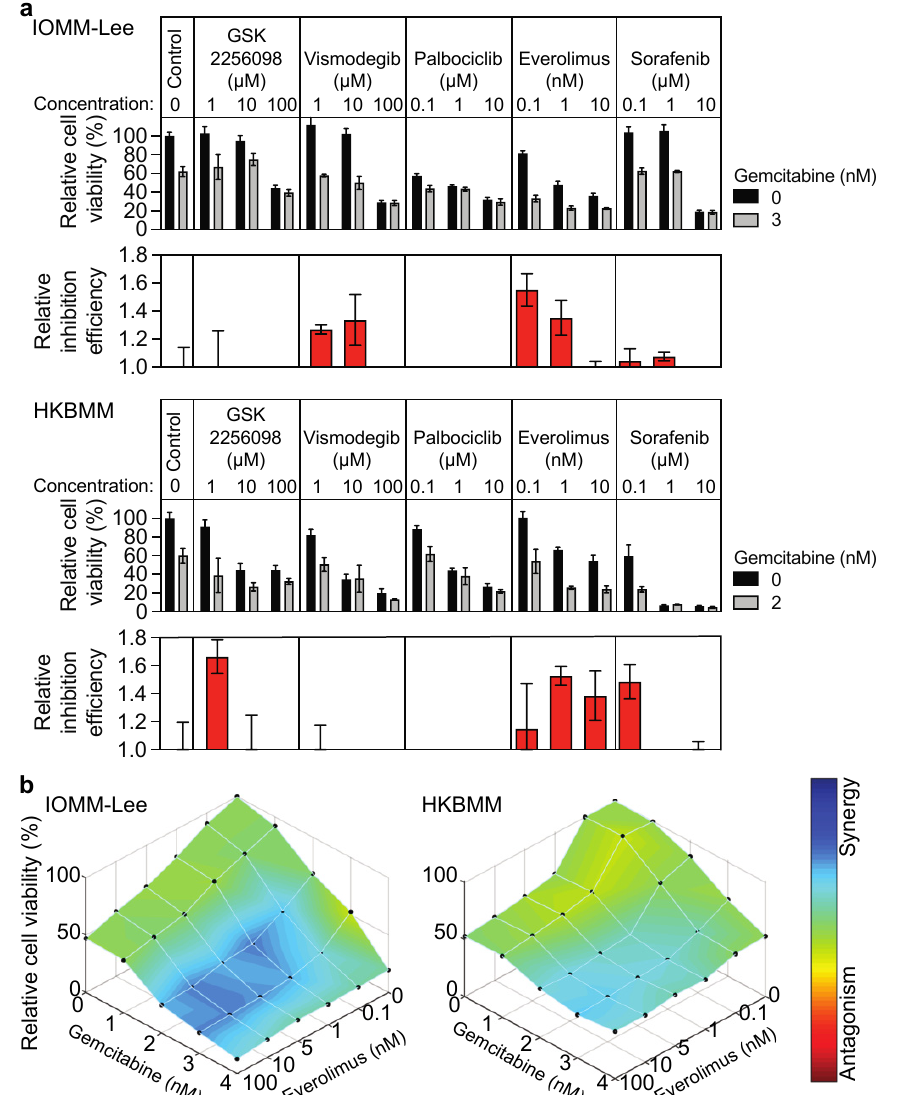
Figure 1. Enhancement of growth inhibitory effects of everolimus by gemcitabine in malignant meningioma cells. ( a ) IOMM-Lee and HKBMM cells plated on 96-well plates in triplicate (500 cells for IOMM-Lee and 2000 cells for HKBMM) were untreated (Control) or treated with the indicated drugs for 4 days in the absence or presence of gemcitabine (3 nM for IOMM-Lee and 2 nM for HKBMM), and cell viability was examined using the WST-8 assay. The percentages of relative cell viability to the control (gemcitabine − and drugs − ) are indicated (upper), and the relative inhibition efficiency values of each drug are shown (lower). The inhibition efficiency of each drug and control (drugs − ) was calculated by the following formula: 1 − [GEM+]/[GEM − ], where [GEM+] and [GEM − ] are the relative cell viability values of cells treated or not with gemcitabine, respectively. The relative inhibition efficiency of each drug was calculated by dividing the inhibition efficiency of each drug by that of untreated cells (drugs − ). ( b ) The combination was evaluated by the WST-8 assay after 4 days in the IOMM-Lee and HKBMM meningioma cell lines. The degree of synergy was evaluated by the Loewe additivity model.